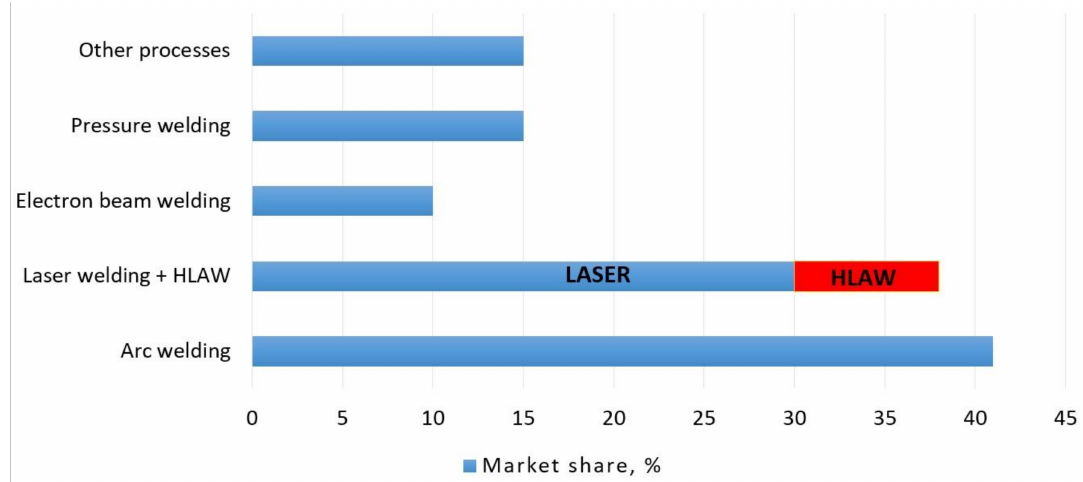
Figure 1. Various welding methods used in joining processes [6].